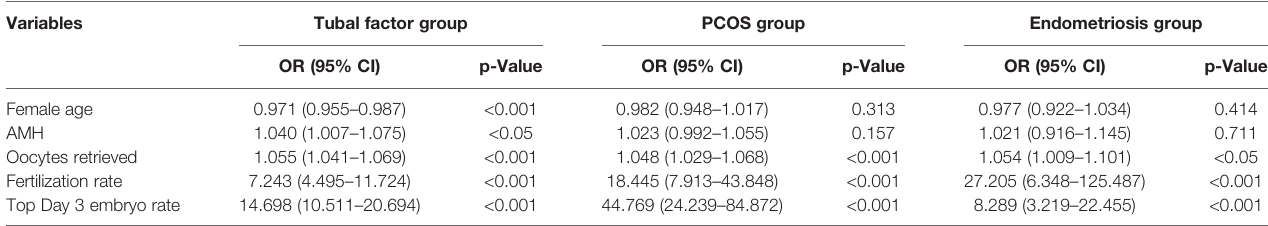
TABLE 4 | Multivariate regression analysis in predictive factors of blastocyst formation in the training cohorts. Variables